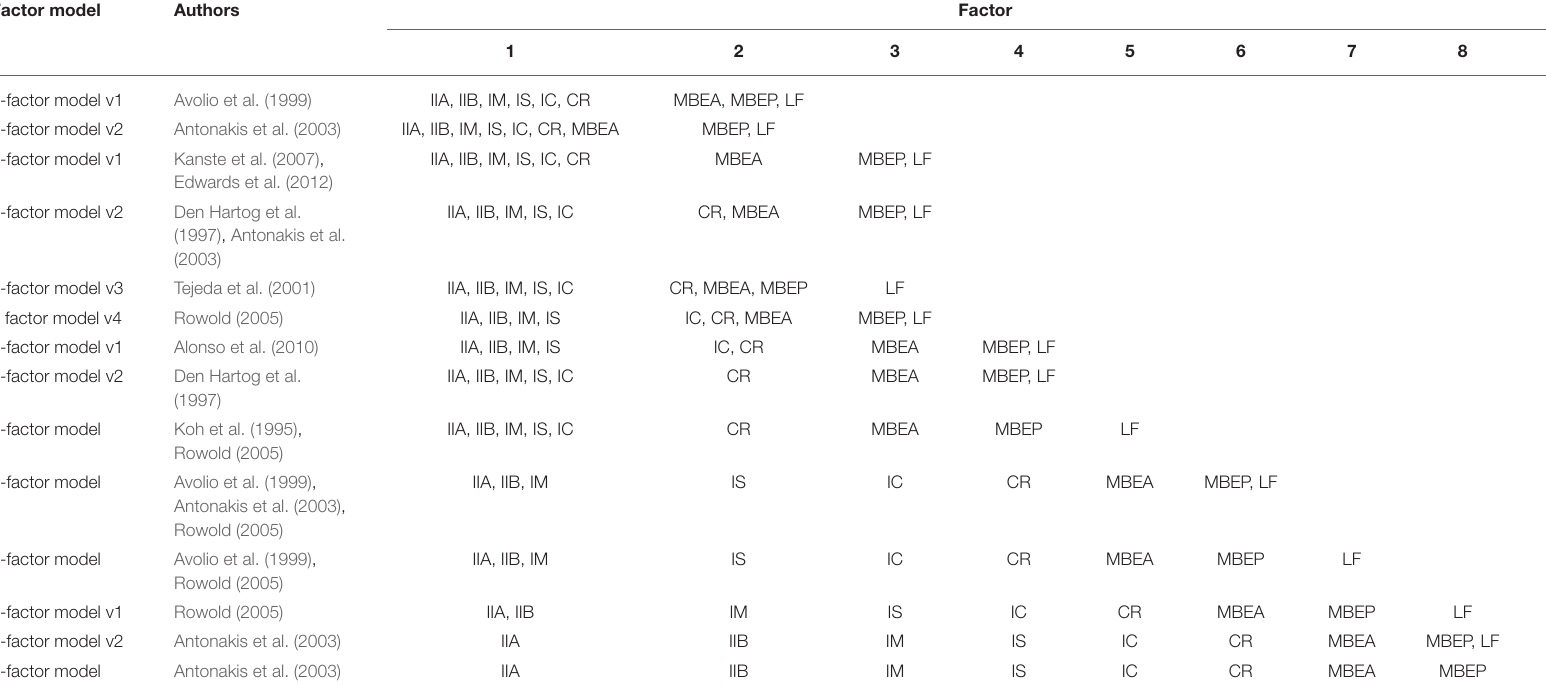
TABLE 2 | The MLQ factor models from previous studies tested in the current study. Factor